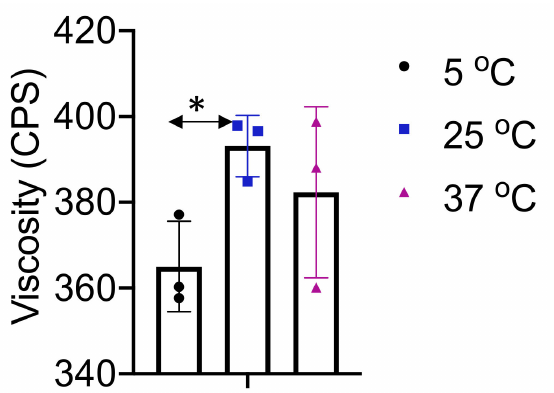
Figure 3. Viscosity testing was performed at various temperatures to determine the optimal temperature during administration, as well as to see if any major change occurred at temperatures similar to contact with human skin. Viscosity remained relatively constant throughout the spectrum, remaining between 355 and 405 centipoise (CPS). All data are presented as mean ± SE ( n = 3). * p < 0.05 compared to 25 ◦